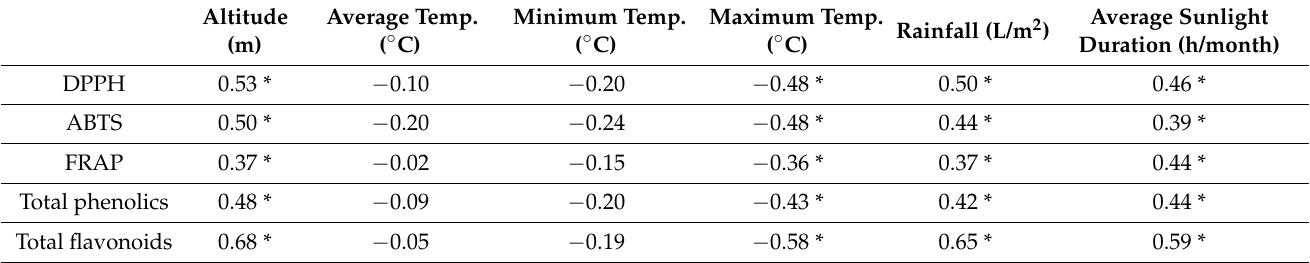
Table 3. Pearson correlation coefficients for antioxidant capacity by the DPPH, ABTS and FRAP assays, total phenolic content, total flavonoids and environmental